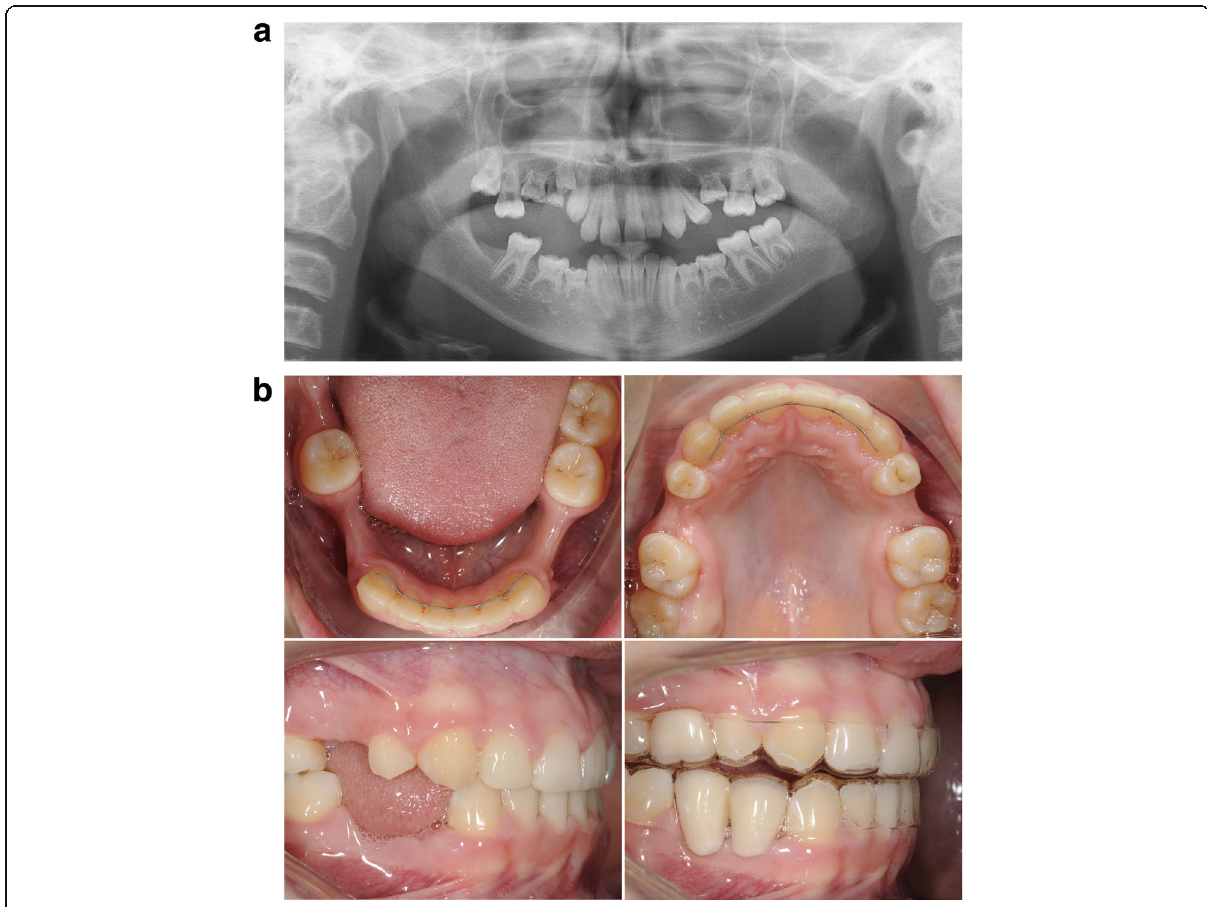
Fig. 1 a Patient 1 — orthopantomogram (OPT) at age of 13. Situation before extraction of the ankylosed deciduous teeth 55, 54, 65, 74, 75, 84, and 85 and start of orthodontic treatment. Eleven permanent teeth (including 4 third molars) were congenitally missing. b Patient 1 — post-orthodontic situation at age of 16. The top of the mandibular processus alveolaris is small ( upper ). The interdental space at location of the second premolars in the maxilla is 7 and 14 mm at location of the premolars in the mandible. Six dental implants were planned (locations 15, 25, 34, 35, 44 and 45). Implant placement (inclusive bone augmentation with the autogenous retromolar mandibular bone 3 months before implant placement at the place of the 25) was postponed until the age of 18. Essix retainers were used to safeguard the width of the